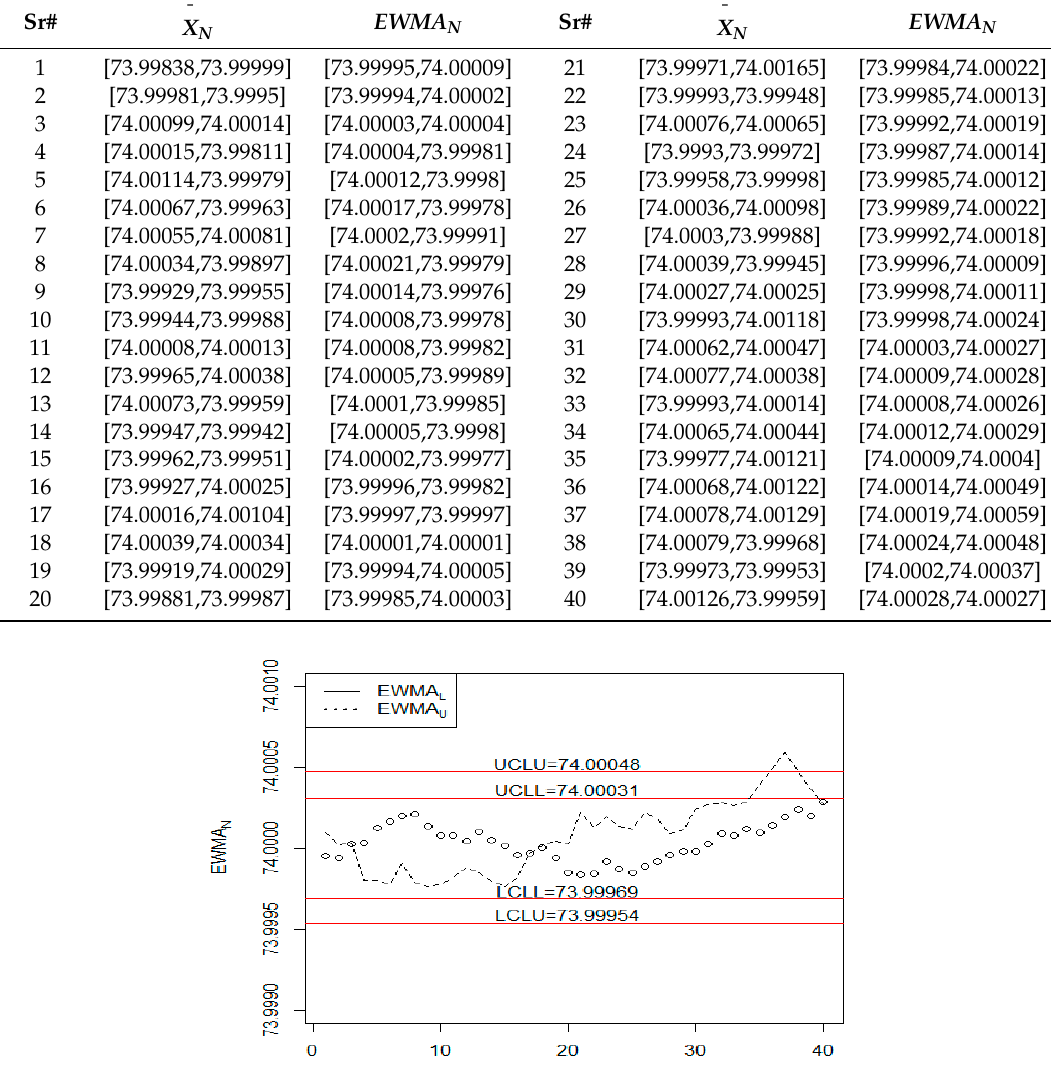
Table 6. The simulated neutrosophic data.